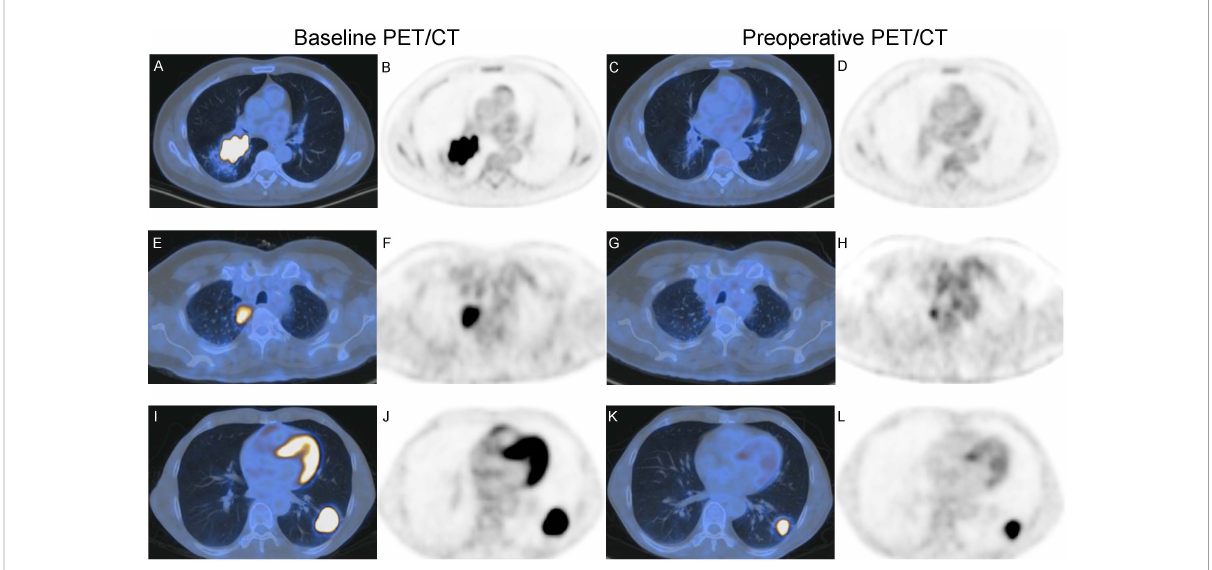
FIGURE 4 Baseline imaging and preoperative PET/CT of two patients with NSCLC receiving neoadjuvant toripalimab with chemotherapy. (A – D) A 58-year- old male with squamous cell lung cancer (SQCC) had CMR according to iPERCIST. (A, B) show baseline axial fused image and PET, SUL peak = 14.0. (C, D) show preoperative axial fused image and PET, SUL peak = 1.44. Resection specimen showed this patient had CPR, consistent with preoperative PET. (E – H) A 65-year-olf male with adenocarcinoma had PMR according to iPERCIST. (E, F) show baseline axial fused image and PET, SUL peak = 7.86. (G, H) show preoperative axial fused image and PET, SUL peak = 2.00. Resection specimen showed this patient had CPR, inconsistent with preoperative PET. (I – L) A 52-year-olf male with adenocarcinoma had PMR according to iPERCIST. (I, J) show baseline axial fused image and PET, SUL peak = 19.0. (K, L) show preoperative axial fused image and PET, SUL peak = 10.5. Resection specimen showed this patient had IPR, consistent with preoperative